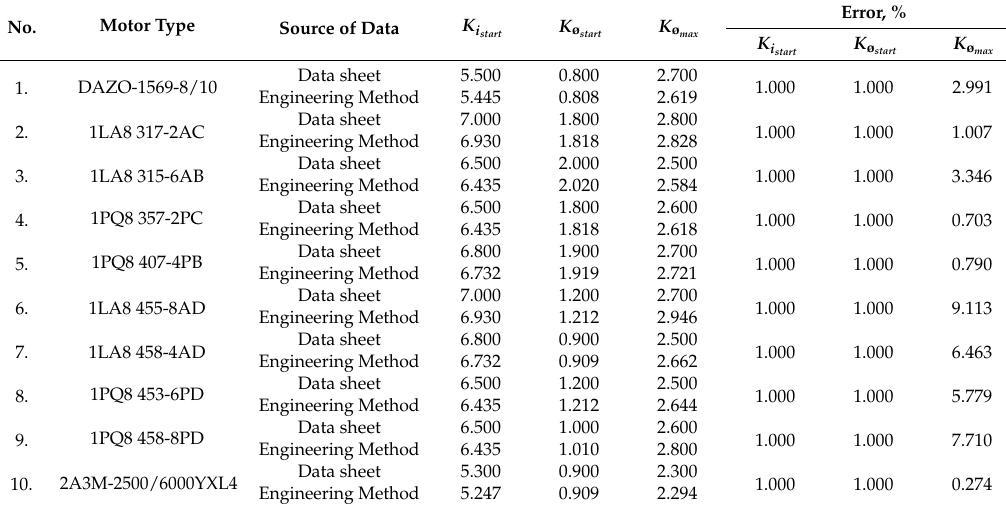
Table 1. Comparison of the manufacturers’ ratios of the starting and pullout torques, and the starting current with those calculated by the engineering